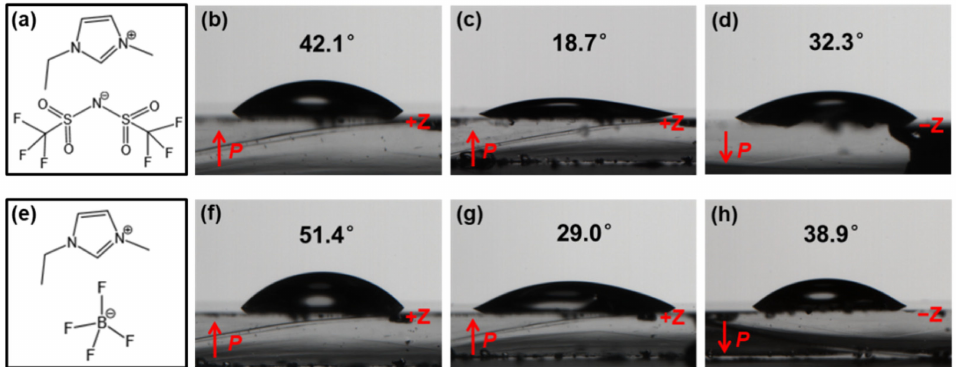
Figure 2. Contact angle of [EMIM][NTf 2 ] and [EMIM][BF 4 ] on the LiNbO 3 substrate ( b , f ) before the heating pretreatment with the +Z surface and after the heating pretreatment with ( c , g ) the +Z surface and ( d , h ) − Z surface. ( a , e ) Chemical structure of [EMIM][NTf 2 ] and [EMIM][BF 4 ]. The surface charge characteristics of the LiNbO 3 substrates before and right after the